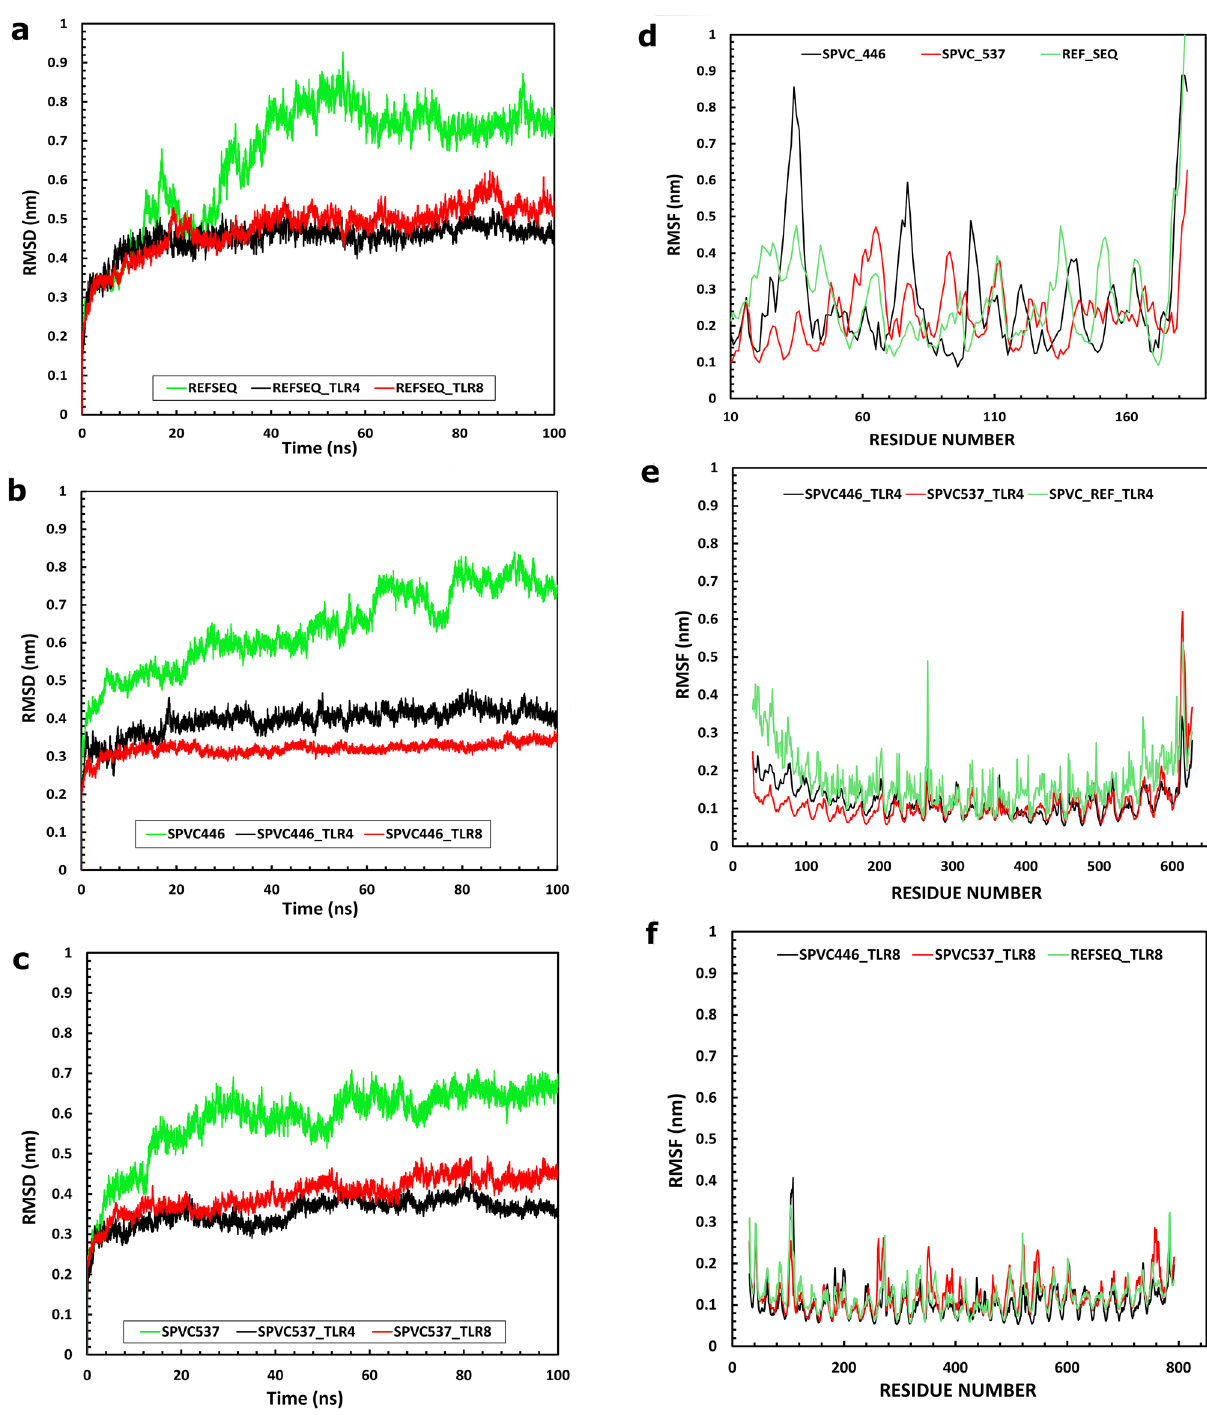
Figure 3. Molecular dynamic simulation studies of each SPVC interactions with TLR4 and TLR8. ( a ) RMSD plot of REF_SEQ, REF_SEQ-TLR4 and REF_SEQ-TLR8 complexes ( b ) RMSD of SPVC_446, ( c ) RMSD of SPVC_537, ( d ) RMSF plot of REF_SEQ, SPVC_446 and SPVC_537, ( e ) RMSF plot of TLR4 in complex with REF_SEQ, SPVC_446 and SPVC_537, ( f ) RMSF plot of TLR8 in complex with REF_SEQ, SPVC_446 and